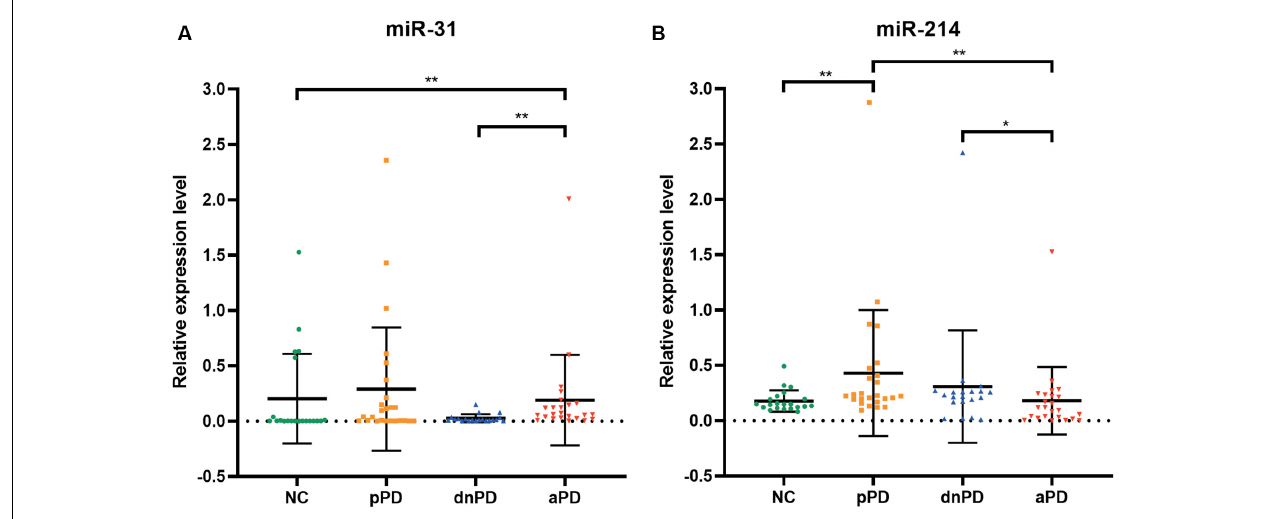
FIGURE 1 | The expression of miR-31 (A) , miR-214 (B) in each group. * P < 0.05, ** P < 0.01.